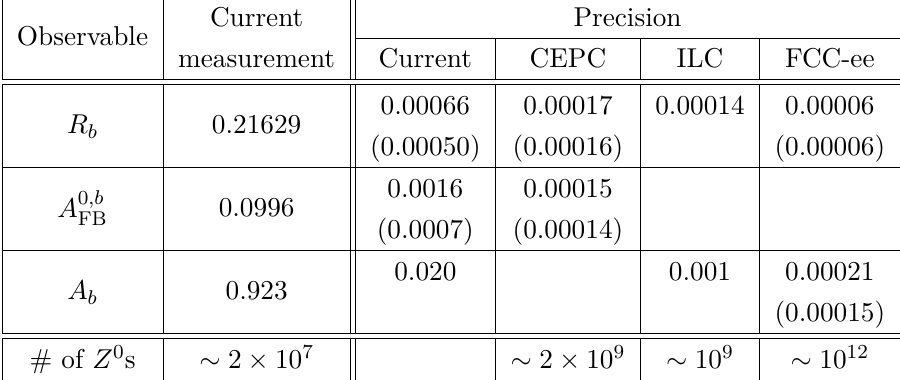
¯ Table 2 . The estimated precision reach for Zb b observables at future e + e − colliders according to ref. [31]. The present result for each observable is shown in the second column. The third column shows the σ of the present measurements at LEP and SLC, respectively, while the other columns show the estimates of the precision reach for the future colliders. In each entry, the number in the top line shows the total uncertainty and the number (in parenthesis) in the bottom line shows the systematic uncertainty. The last row shows the expected number of Z 0 events that will be